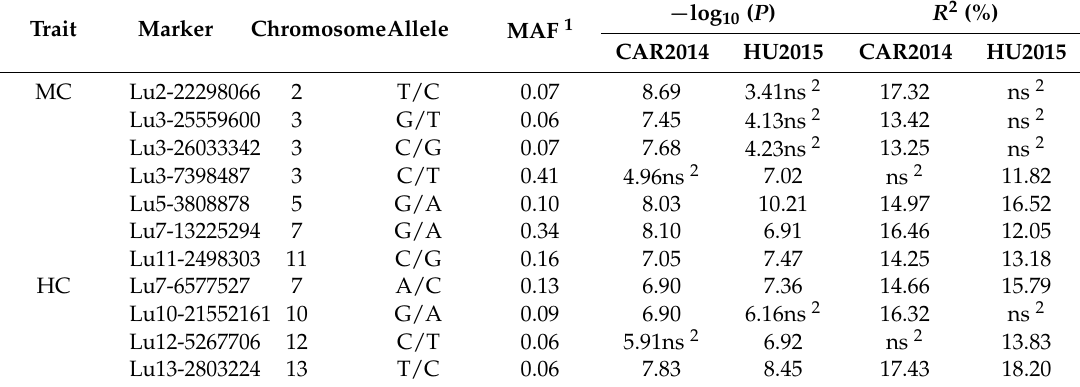
Table 1. Genome-wide significant peak SNPs for mucilage content (MC) and hull content (HC). Trait Marker ChromosomeAllele MAF